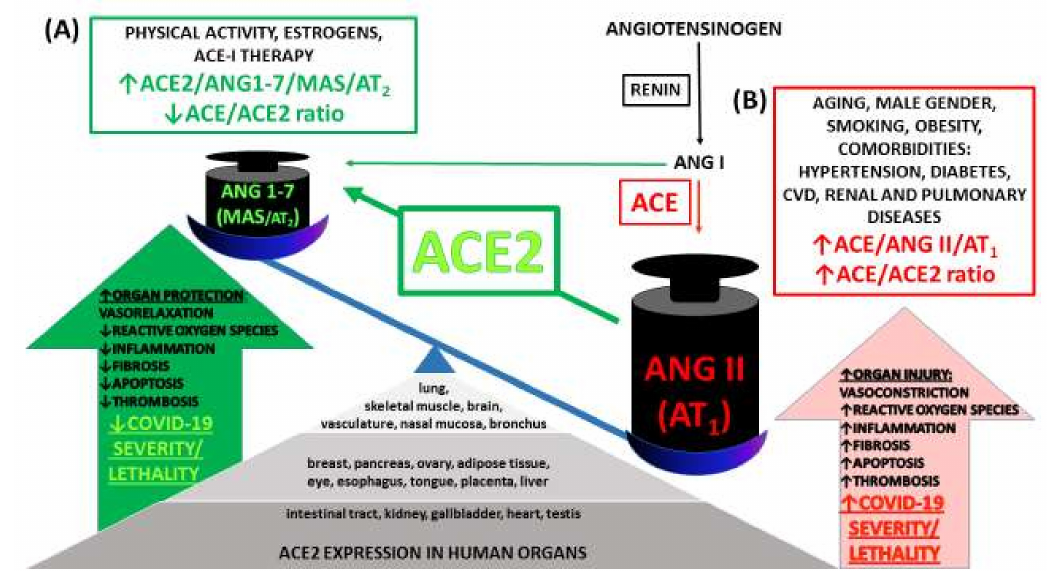
Figure 1. Expression of angiotensin-converting enzyme 2 (ACE2) in human tissues and organs, its counter-regulatory effects on the ACE → Ang II → AT 1 axis and interaction with coronavirus disease 2019 (COVID-19). ACE2 is ubiquitous and widely expressed in many organs targeted and damaged by COVID-19 caused by severe acute respiratory syndrome coronavirus